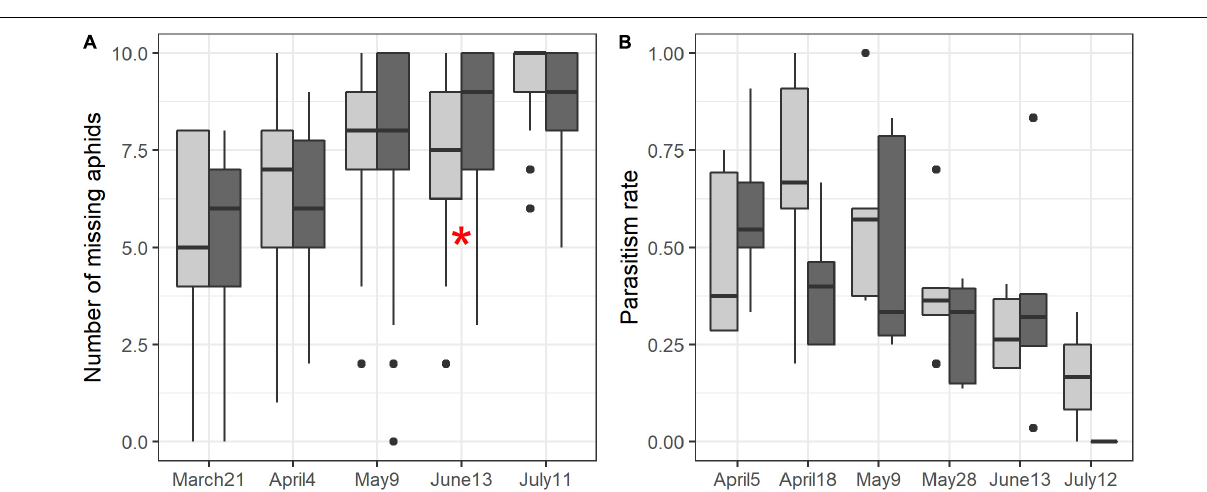
FIGURE 8 | Variations of aphidophagy service (A) and parasitism service (B) over time and according to soil management (light gray: conventional, dark gray: conservation). Red asterisk reflects significant difference between soil managements at a specific sampling